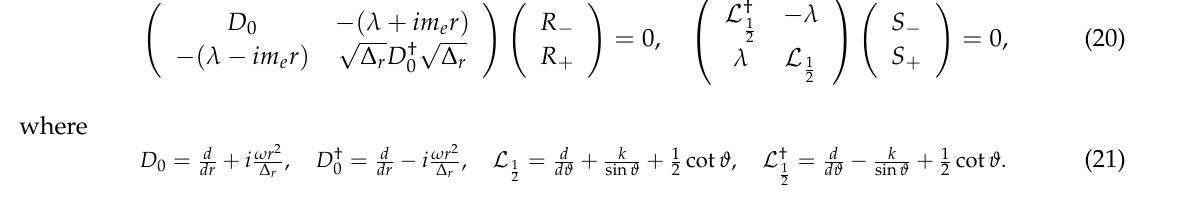
Table 1. Table of spin coefficients for different choices of the null